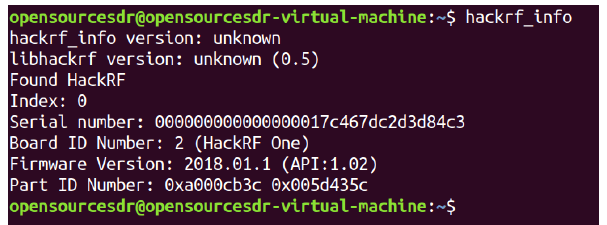
Figure 18. Test whether the host is installed successfully.